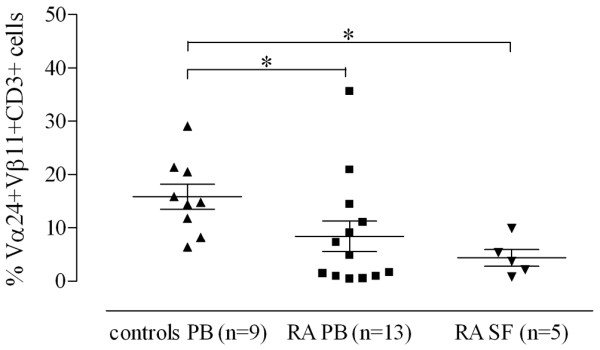
Reactivity of peripheral blood (PB) and synovial fluid (SF) derived natural killer T (NKT) cells to α-galactosylceramide (α-GalCer). PB mononuclear cells (1.5 × 106 cells/well) of nine healthy control individuals and 13 rheumatoid arthritis (RA) patients as well as SF mononuclear cells of five RA patients were stimulated with α-GalCer and re-stimulated on day 7 with autologous, α-GalCer pulsed, irradiated PB mononuclear cells in the presence of 2 U/ml IL-2. NKT cell numbers were determined by flow cytometry at day 14. Error bars indicate standard error of the mean. *P < 0.01.